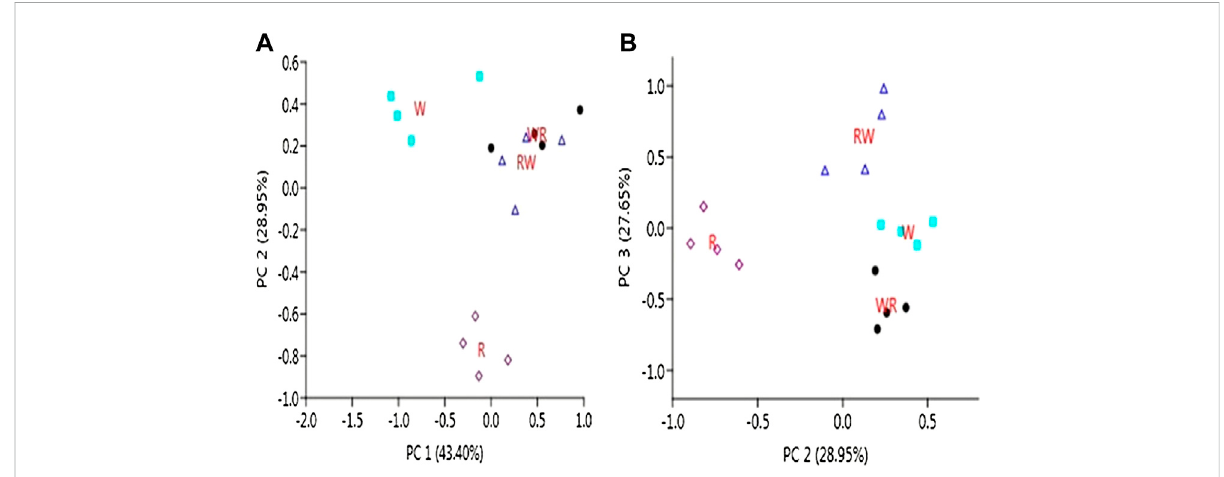
FIGURE 2 Separation of the pure lines and reciprocal hybrids by PCA (A) : PC1 vs. PC2 plot (B) : PC2 vs. PC3 plot.